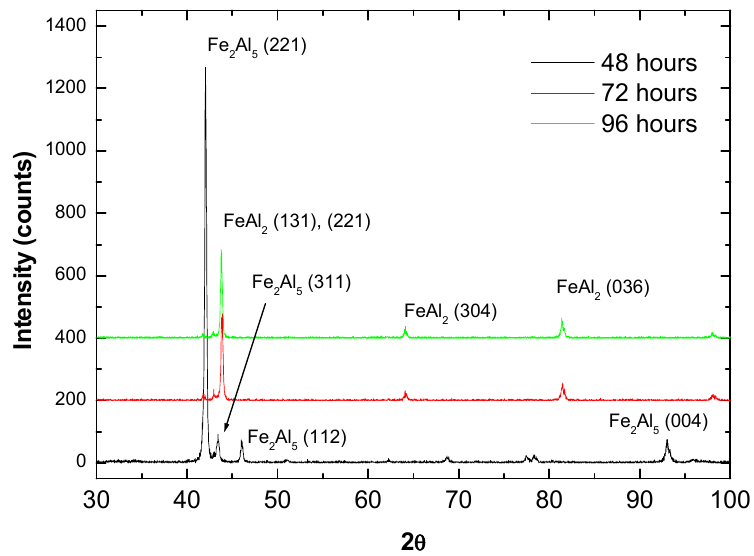
Figure 6. XRD analysis of the coatings after heat treatment at 550 °C for 48, 72 and 96 h indicating a conversion from Fe 2 Al 5 to FeAl 2 with time.